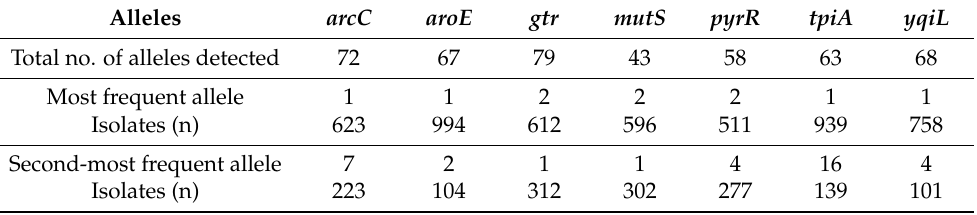
Table 1. Details of alleles detected across all 7 genes evaluated in S. epidermidis isolates in the